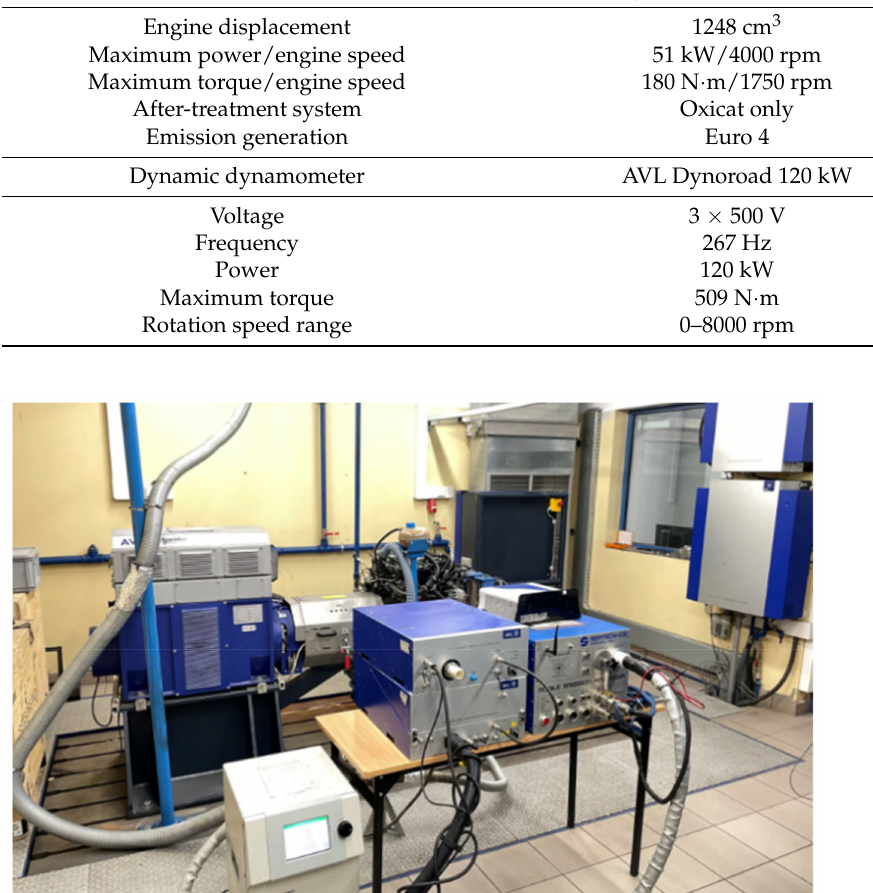
Figure 2. View of the laboratory test